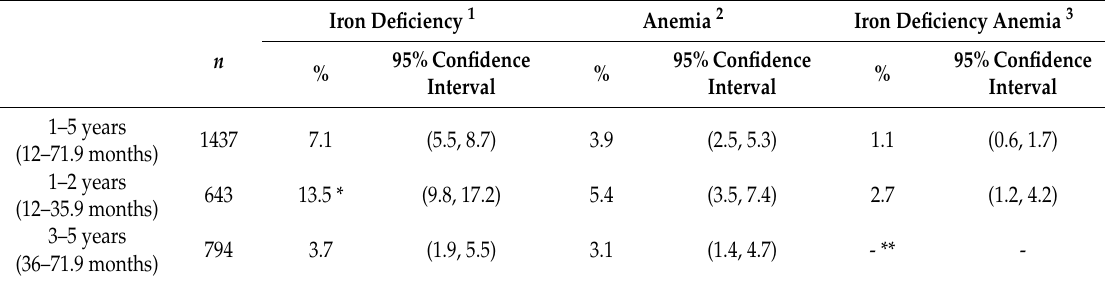
Table 1. Prevalence of iron deficiency, anemia, and iron deficiency anemia among children 1–5 years in the United States, National Health and Nutrition Examination Survey (NHANES)